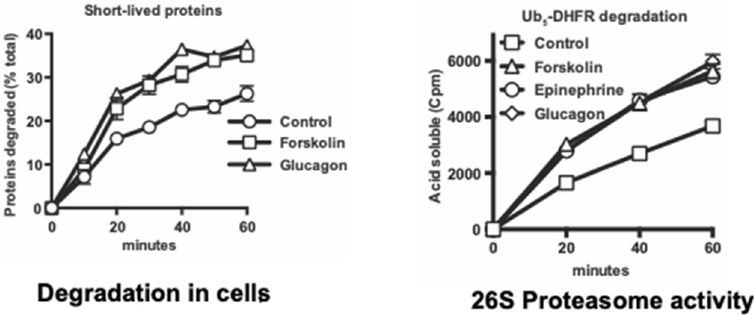
Figure 6. In mouse hepatocytes, glucagon and epinephrine, like forskolin, rapidly stimulate break- down of short-lived proteins and the proteasomes’ ability to degrade ubiquitinated substrates. (Left Panel) Short-lived proteins in primary mouse hepatocytes were initially labeled for 20 min with 3 H-phenylanine, as described previously [62,64]. After labeling and re-suspension in chase medium, degradation was measured in the presence of glucagon or forskolin. (Right Panel) 26S proteasomes were purified by the UBL method from (nonlabeled) mouse hepatocytes treated for 1 h with either forskolin, epinephrine, glucagon, or the vehicle. These treatments increased the ability of proteasomes to degrade the model UPS substrate, ubiquitinated 32 P-labeled dihydrofolate reductase (adapted from [16]).